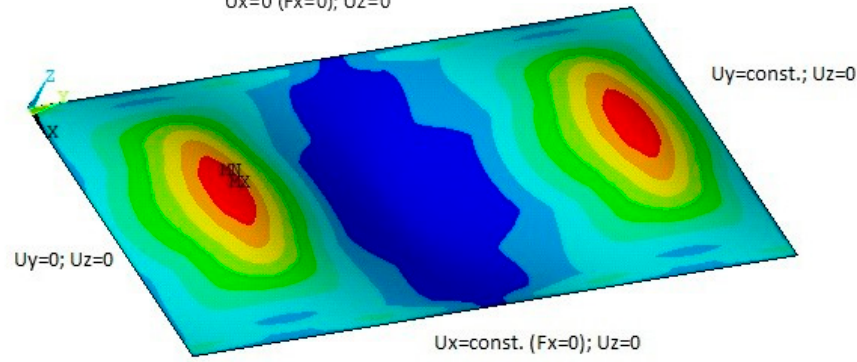
Figure 5. Boundary conditions on a rectangular plate loaded longitudinally (constrained conditions).